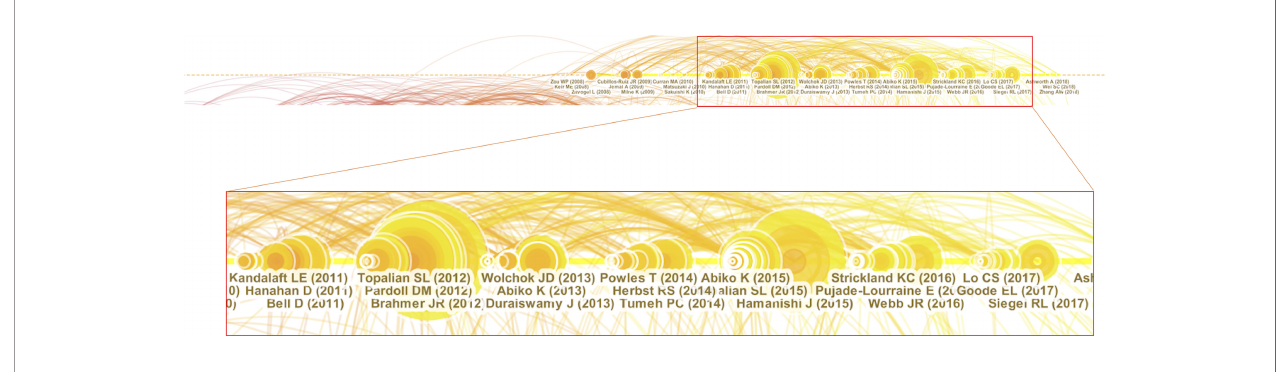
FIGURE 6 | High impact members in